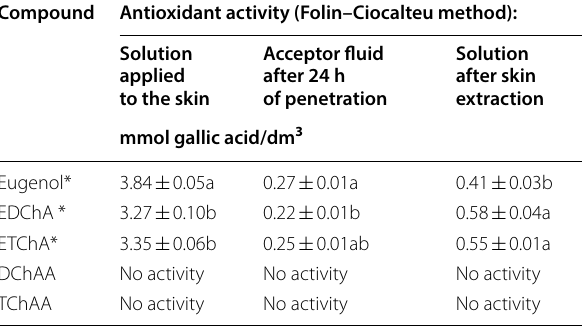
Table 4 Total polyphenol content in solutions of test compounds applied to the skin, acceptor fluid solutions obtained after 24 h of collection, and solutions obtained after skin extraction Compound Antioxidant activity (Folin–Ciocalteu method):